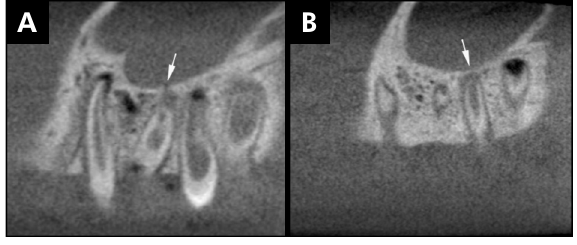
Figure 3. Sagittal CBCT images: A) Sample with oroantral com- munication (arrow) caused by periapical lesion; B) Sample without disruption of cortical sinus (arrow) close to periapical